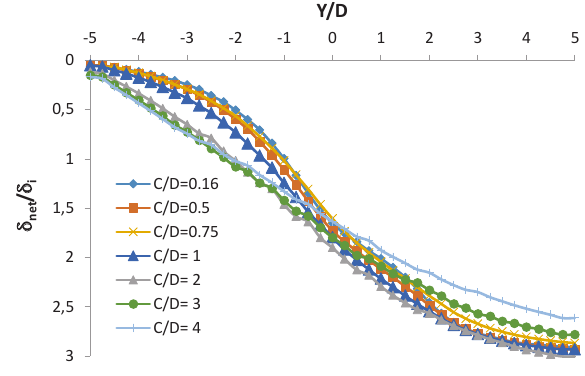
Fig. 13 Distributions of normalized net pile head settlement with tunnel advancement for various C/D (single pile).